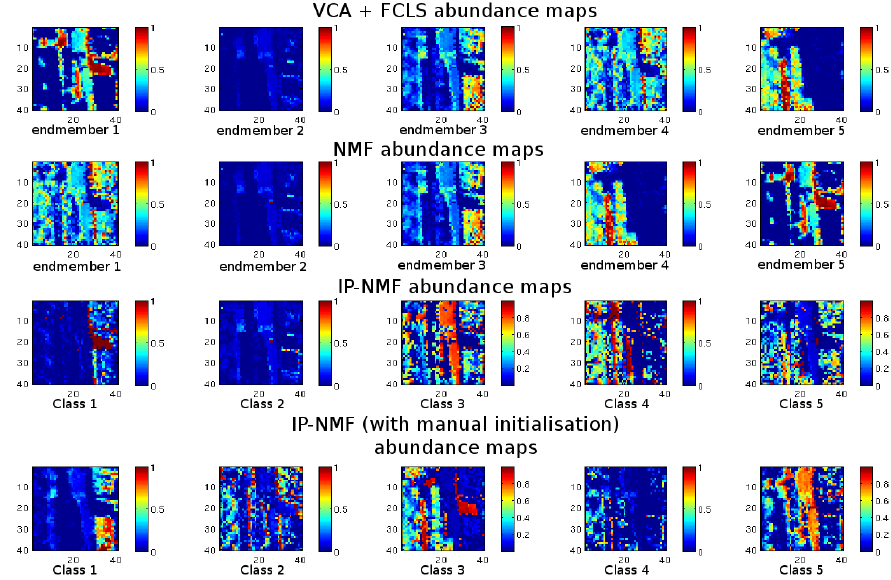
Figure 13. Abundance maps obtained for M = 5 with four methods: VCA + FCLS (1st line), standard NMF (2nd line), IP-NMF initialised with VCA (3rd line) and IP-NMF initialised with manually selected spectra (4th